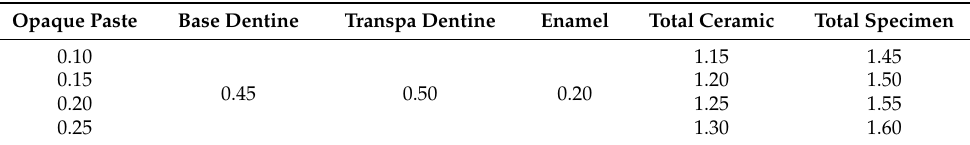
Table 3. Thicknesses of the combination tested